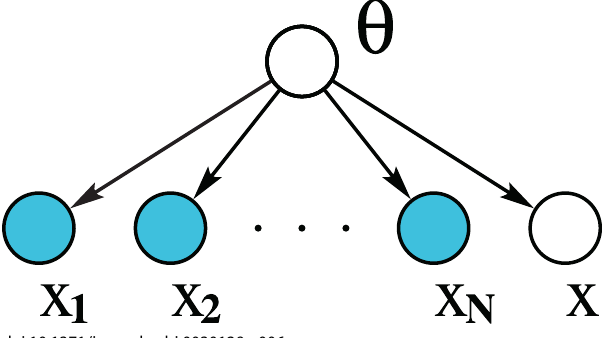
Figure 6. Graphical Model Illustrating Bayesian priors and training set sizes. Both ML and MAP produce a point estimate for h . Point estimates are a single snapshot of parameters (though confidence intervals on their values can be calculated).